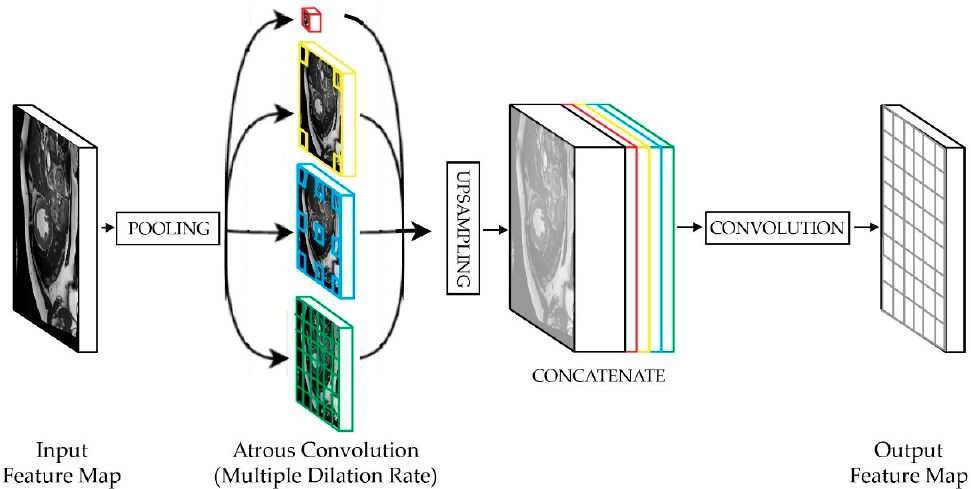
Figure 6. In ASSP, the atrous convolution uses a parameter called the dilation rate that adjusts the field of view to allow a wider receptive field for better semantic-segmentation results. By increasing the dilation rate at each block, the spatial resolution can be preserved, and a deeper network can be built by capturing features at multiple scales.